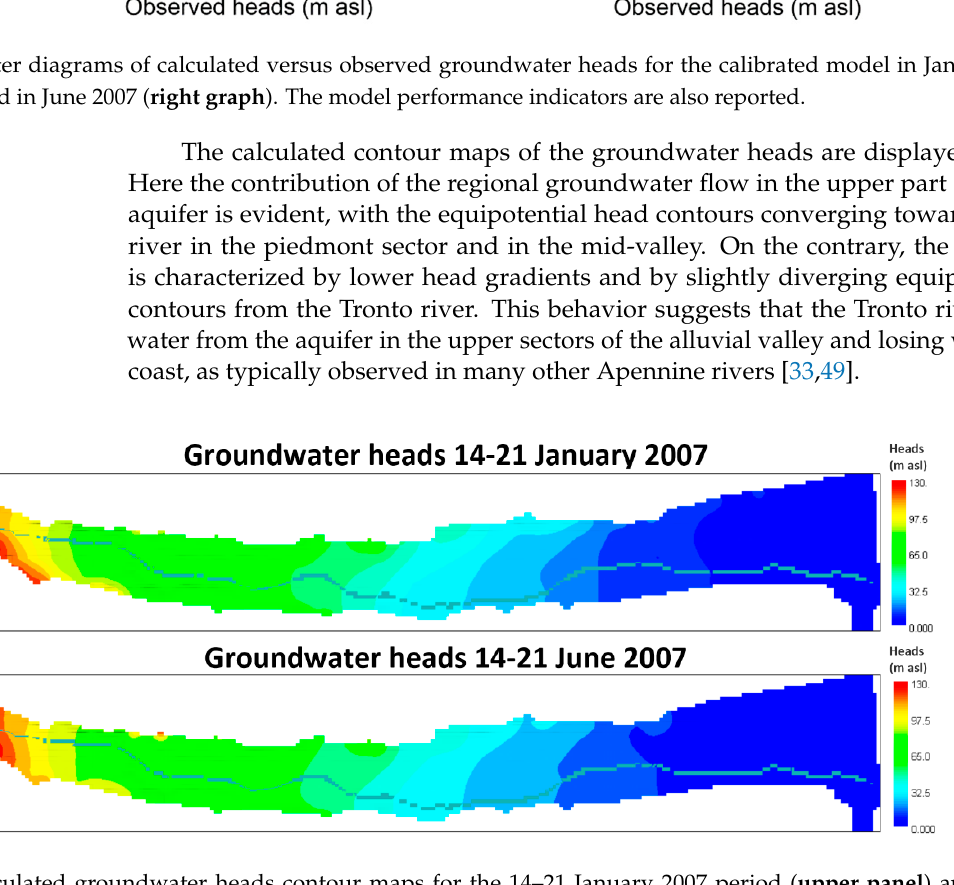
Figure 5. Calculated groundwater heads contour maps for the 14–21 January 2007 period ( upper panel ) and for the 14–21 June 2007 period ( lower panel ), the Tronto RIVER package (RIV) cells are also displayed (grey blue cells).